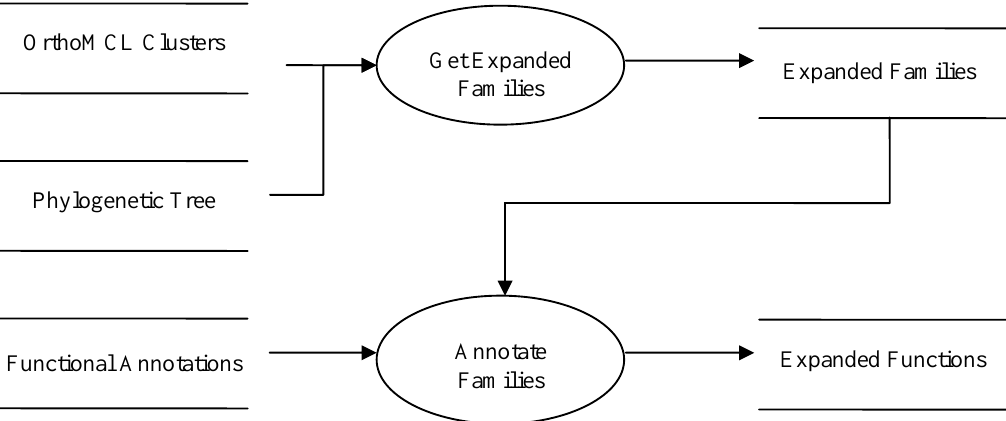
Figure 3: A data flow diagram for detecting and interpreting redundancy.